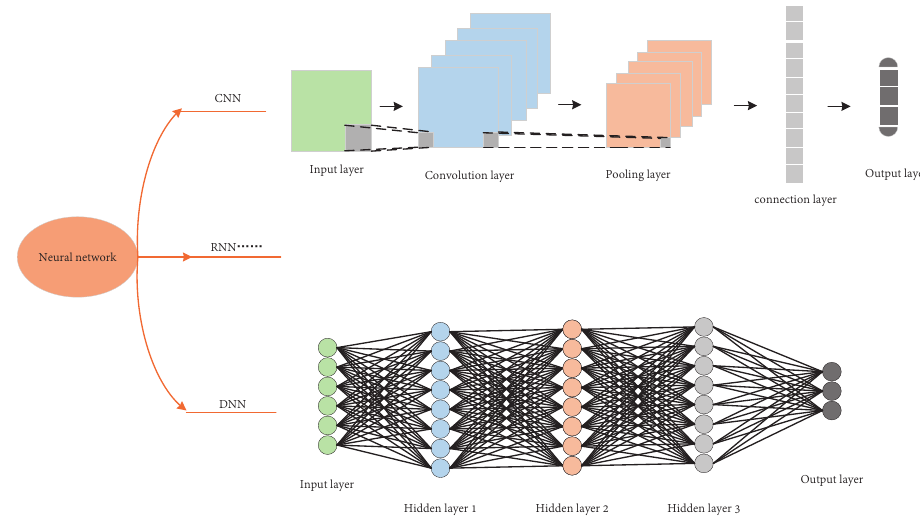
Figure 23. Structural block diagrams of a CNN and